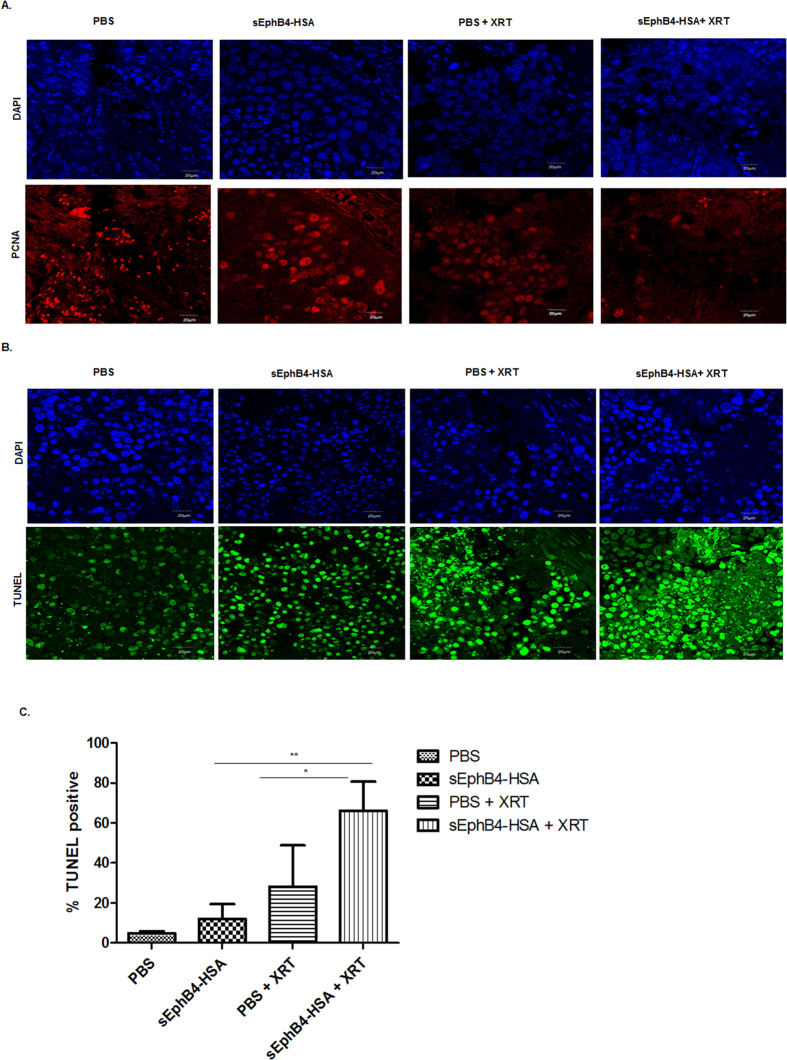
EphB4 targeting radiosensitizes HNSCC tumors and affects tumor growth by reducing proliferation, and enhancing apoptosis.Immunofluorescence analysis of CUHN013 PDX tumors show reduction in PCNA (A) and enhancement in TUNEL-positive nuclei (B) in mice treated with sEphB4-HSA and ionizing radiation (XRT) compared to mice treated with a single agent. Quantitative analysis of TUNEL staining (C) show significant increase in apoptosis as evident by TUNEL-positive nuclei in the combination group compared to single agents. Data shown represent mean ± standard deviation. *p < 0.05, **p < 0.005. Total magnification: 600x.